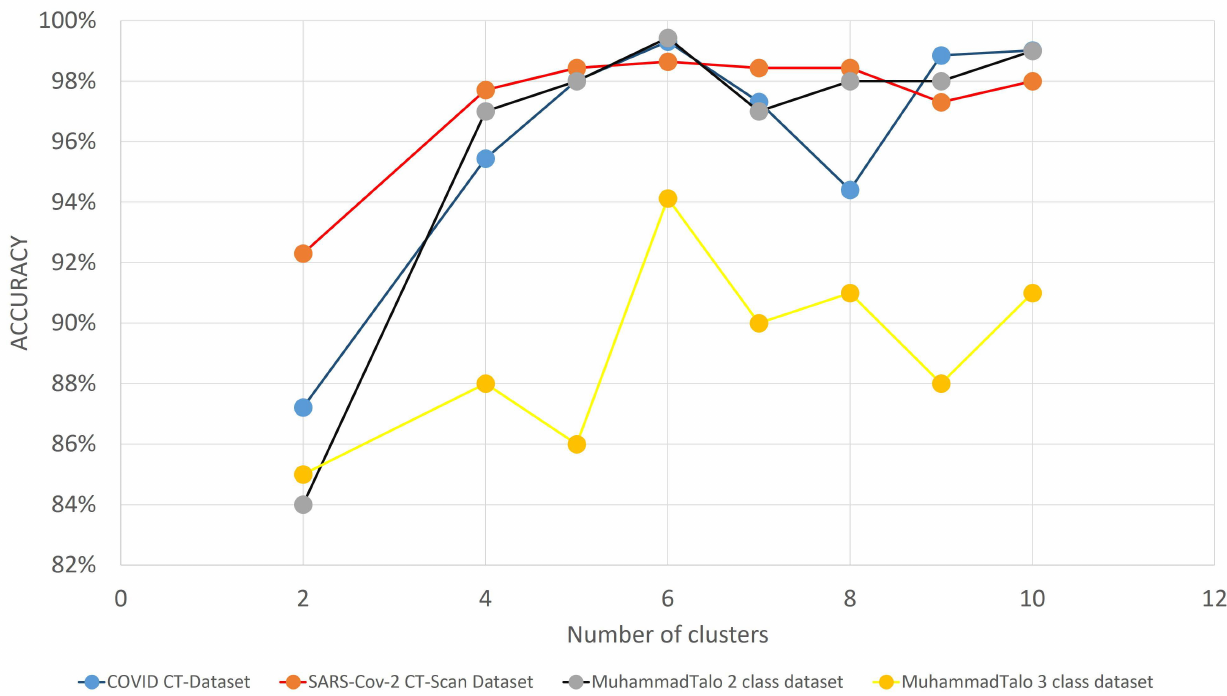
Figure 11. Graph showing the variation of classification accuracies with respect to the number of clusters for three COVID-19 datasets.